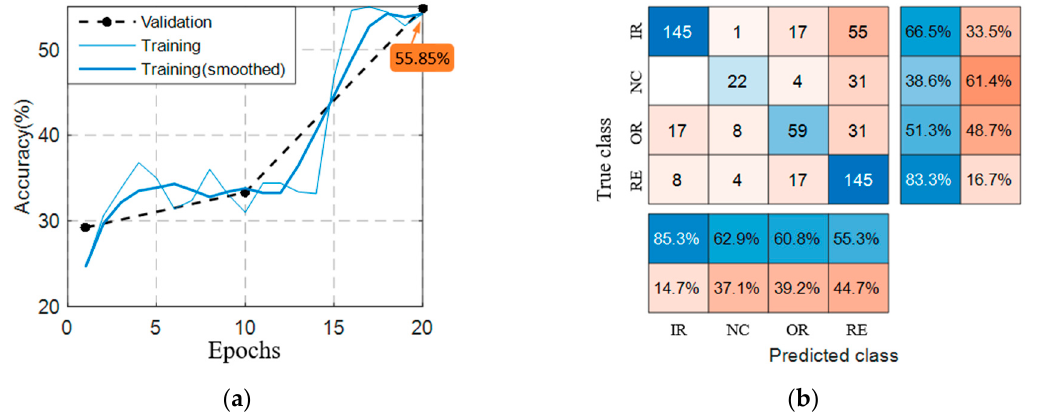
Figure 10. The detail results of FD-Net in the accuracy level S1: ( a ) The training and validation process of DCNN (55.85%); ( b ) The fusion matrix of the related Ada-DCNN (65.78%).